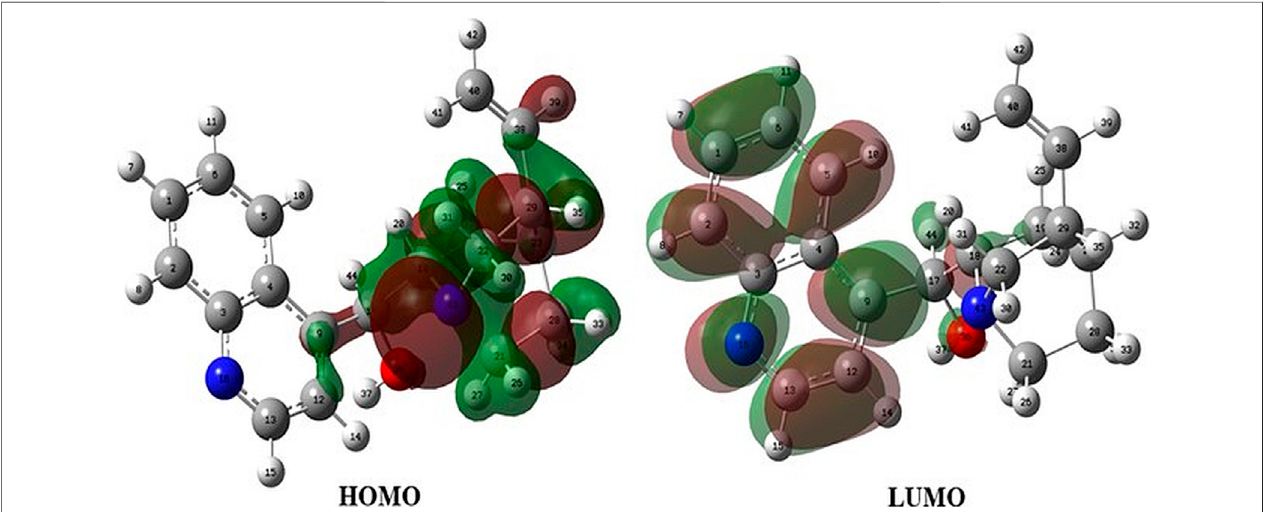
FIGURE 3 | HOMO and LUMO of epi-cinchonidine.